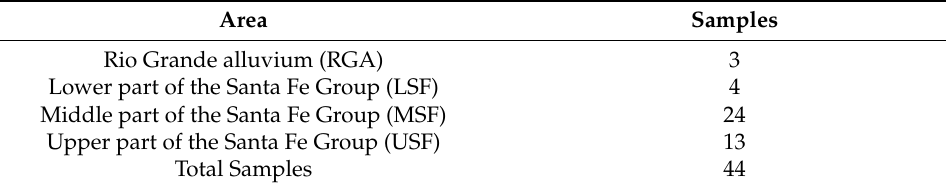
Table 1. Samples in the Mesilla Basin aquifer by Teeple (2017) [11]. Area Samples Rio Grande alluvium (RGA) 3 Lower part of the Santa Fe Group (LSF) 4 Middle part of the Santa Fe Group (MSF) 24 Upper part of the Santa Fe Group (USF) 13 Total Samples 44